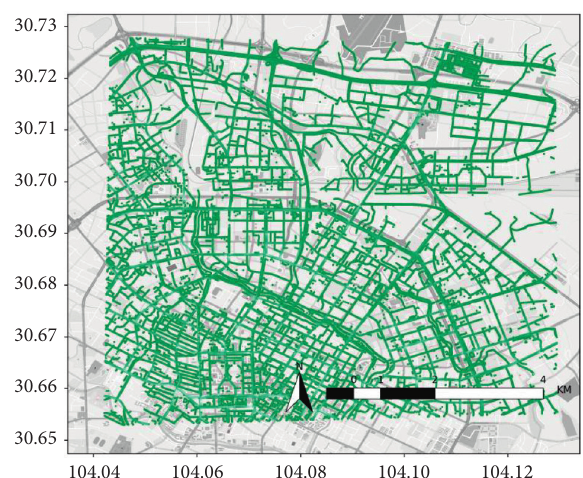
Figure 1: GPS data of online ride-hailing in Chengdu